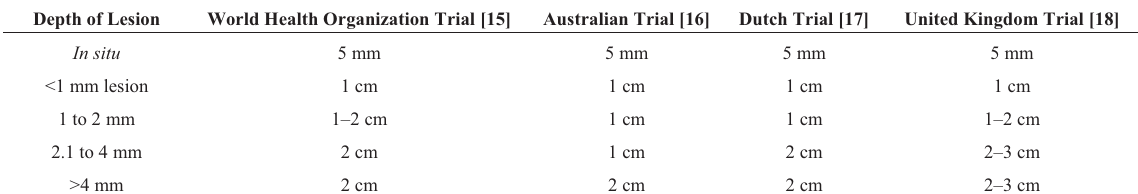
Table 1. Recommended excision